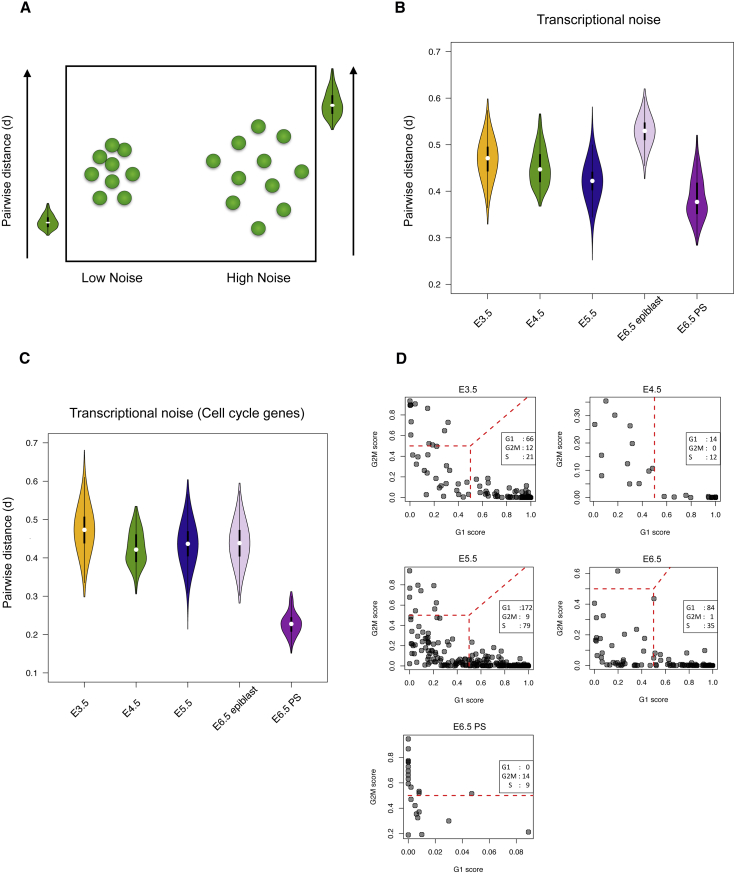
Transcriptional Noise across Each Developmental Stage(A) Cartoon illustrating the concept used to calculate transcriptional noise. The method is based on cell-cell correlations within homogeneous populations.(B) Plot showing transcriptional noise across all stages of epiblast development and the primitive streak (PS).(C) Plot showing transcriptional noise of cell-cycle genes across all stages of epiblast development and the primitive streak (PS).(D) Separation of cells at each stage or lineage by cell-cycle phase. Number of cells at each cell-cycle stage is shown in the inset.